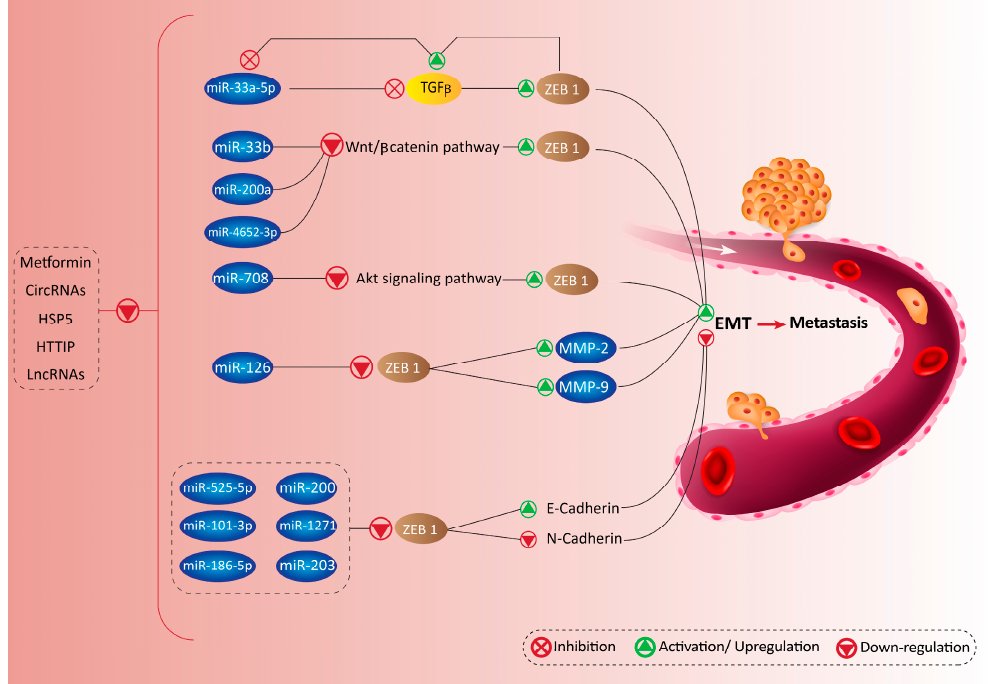
Figure 2. Metformin, lncRNAs, circRNAs, and other molecular pathways are able to function as upstream mediators of miRs in targeting ZEB proteins, and promote cancer progression.